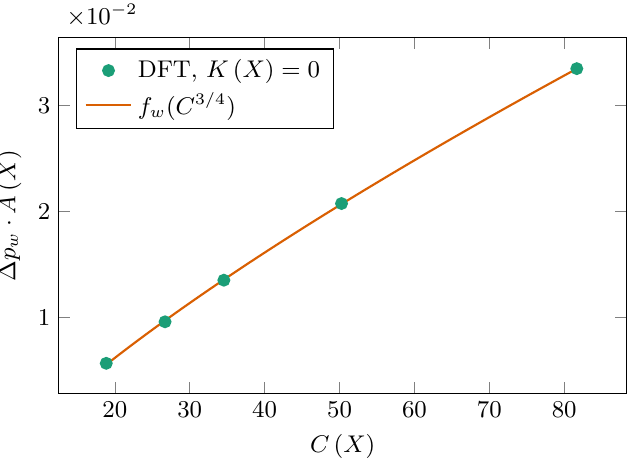
Figure 4. Dimensionless pressure difference between the continuous phase transition associated with adsorption of gas onto a wall in the bulk and inside a pore times the surface area Minkowski functional, ∆ p w · A ( X ) , as function of circumference Minkowski functional, C ( X ) . The Minkowski functional for topology is zero in all the shown simulations, K ( X ) = 0. The curve fit is equal C 3/4 , where the Minkowski functional C ( X ) only depends on r p . The to: f w ( C 3/4 ) = Ω lg + σ (cid:48) lg = 1.538 × 10 − 3 ± 0.008 × 10 − 3 . In coefficients are: Ω lg = − 8.3 × 10 − 3 ± 0.1 × 10 − 3 and σ (cid:48) lg dimensional form, from left to right the pressure differences are 1.8 kPa, 1.3 kPa, 1.0 kPa, 0.69 kPa, and 0.40 kPa.